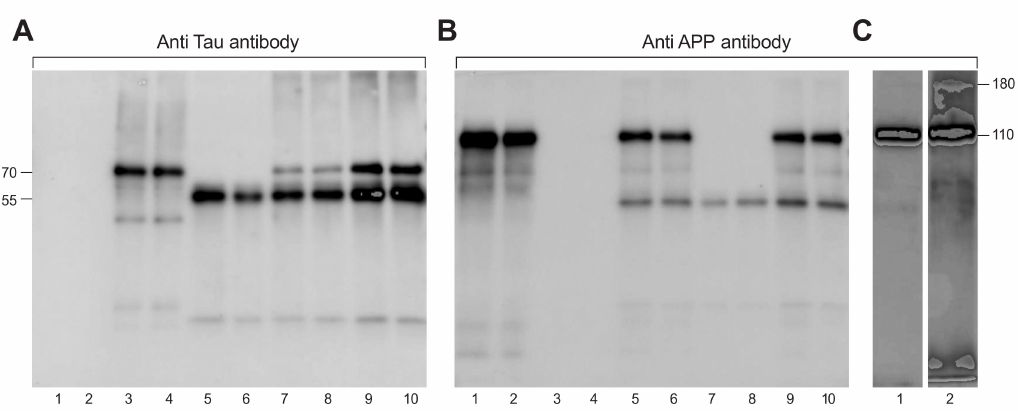
Figure 1. Western blot of APP and Tau protein binding and crosslinking of the proteins. Samples loaded in duplicates in blots A and B. In blots ( A , B ) Lanes 1 and 2 are loaded with 50ng APP protein / lane. Lanes 3 and 4 are loaded with 50ng / lane Tau protein. APP-His protein bound to protein A / G beads, previously coupled with anti-His antibodies are loaded on lanes 5 and 6. Tau protein bound to protein A beads coupled with anti-His antibodies are loaded in lanes 7 and 8. In the last two lanes, 9 and 10 of A and B, a mixture of APP and Tau proteins was loaded. The mixture was performed by binding APP-His protein to protein A / G beads, previously coupled with anti-His antibodies, and then Tau protein was added (Materials and Methods section). Membrane ( A ) was developed with anti-Tau antibody and was overexposed to enable detection of any non-specific binding of Tau (70 kD), also causing overexposure of the IgG band (55 kD). The faint band of Tau seen in Figure 1A, lanes 7 and 8 is non-specific as Tau was bound to a negative control protein (45 kD bacterial protein-His). Therefore, we concluded that the strong tau band seen in lanes 9 and 10 was specific binding of Tau to APP. Membrane ( B ) was developed with anti- A β antibody (6E10) and shows the 110 kD band of APP protein. Membrane ( C ) was loaded with APP protein on lane 1 and with a mixture of APP and Tau, crosslinked on lane 2 (Materials and Methods